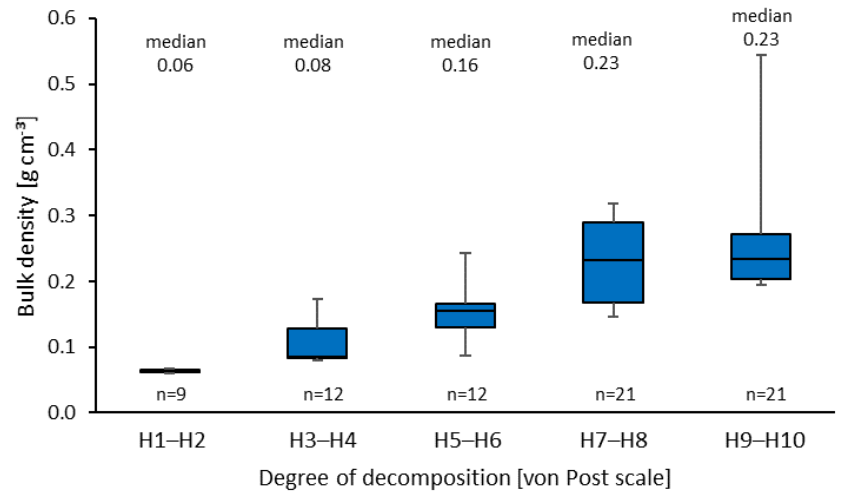
Figure 4. Bulk density versus degree of decomposition of the investigated soil profiles. Boxplot showing median, interquartile range, minimum and maximum of bulk density versus degree of